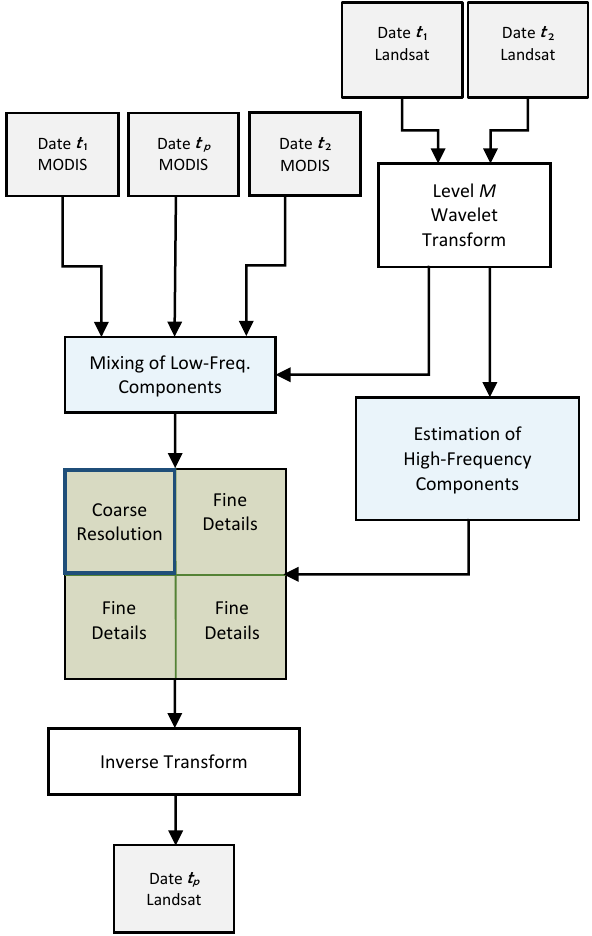
Figure 6. Proposed fusion model using two time instants, t 1 and t 2 , to estimate a Landsat image at intermediate time t p .